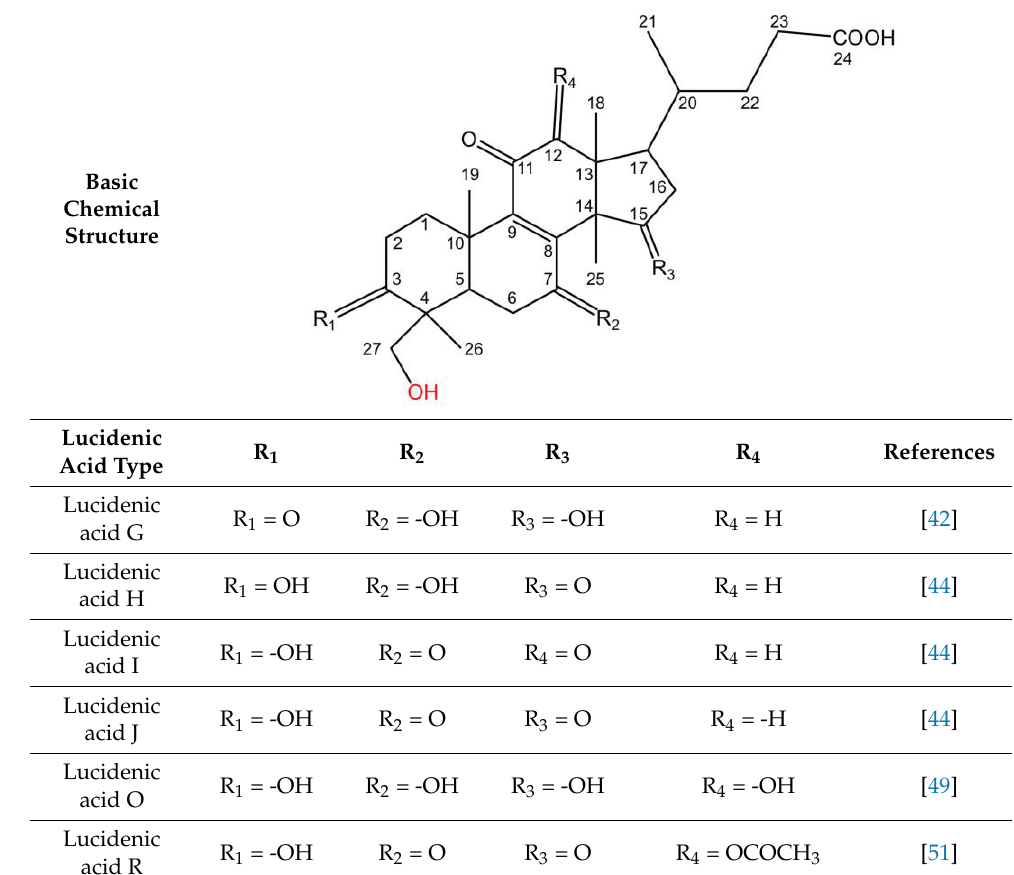
Table 3. Chemical structures of lucidenic acids G, H, I, J, O and R.